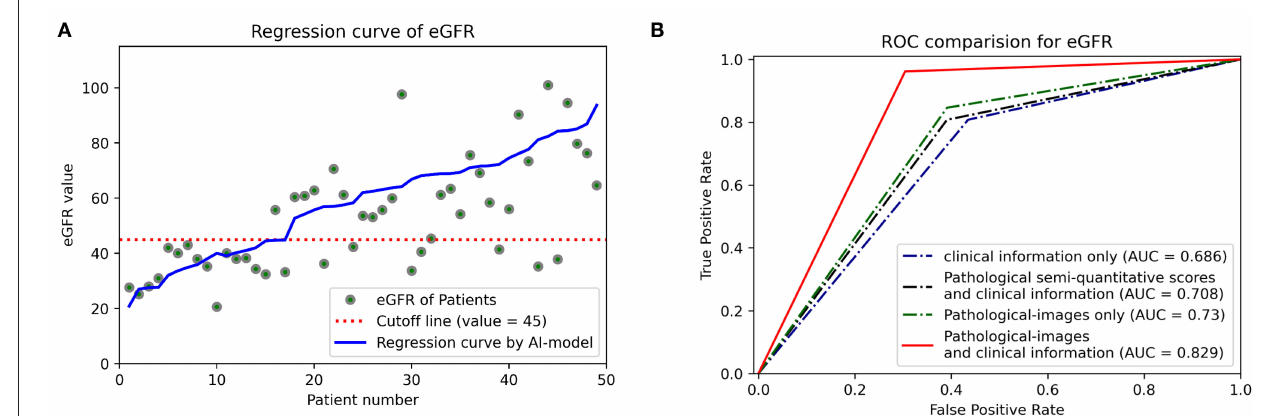
FIGURE 5 | (A) Estimated glomerular filtration rate regression curves. The predictive values of 49 patients are arranged in ascending order, and the corresponding actual values (green dots) and their regression curves (blue lines) are indicated. Cutoff lines (red dashed lines) are also added to facilitate classification. (B) Receiver operating characteristic curves (ROCs) and areas under the ROC curve (AUCs) were used to show the binary classification results of the different models to predict whether eGFR is higher than 45 ml/min/1.73 m 2 .